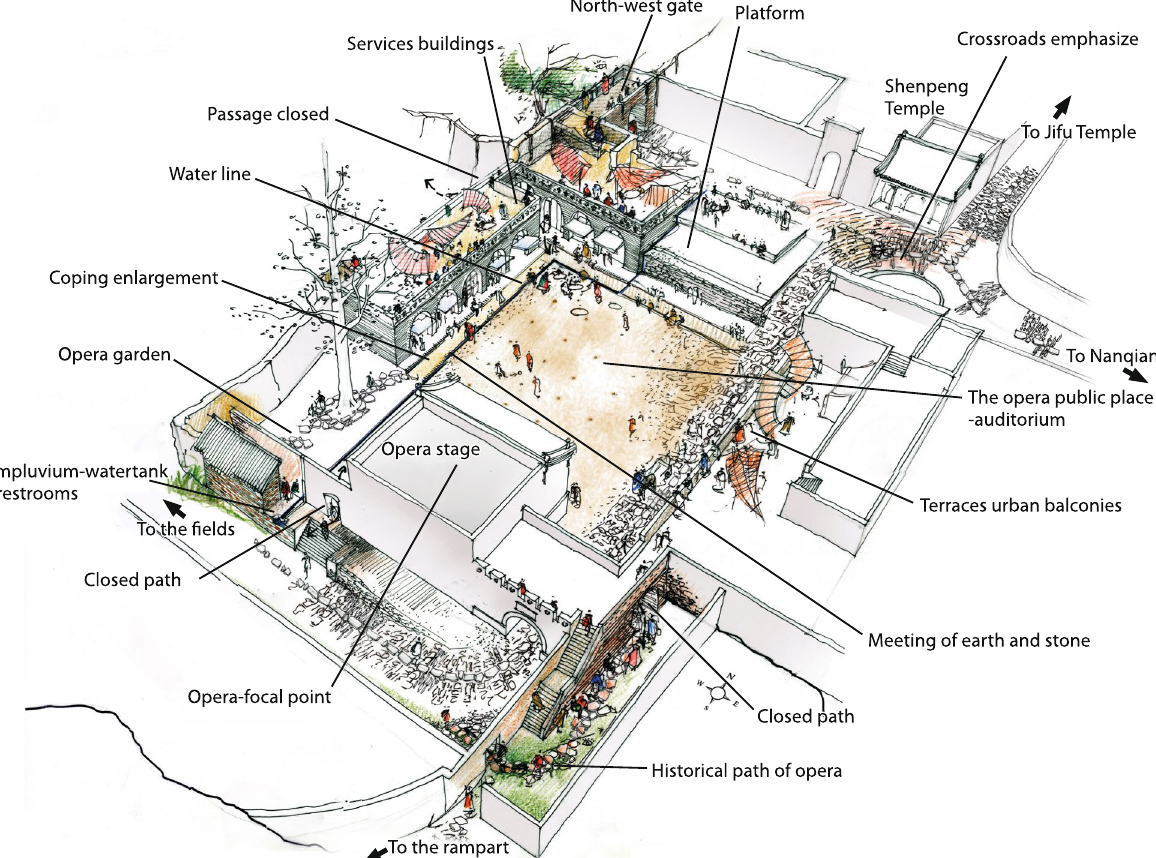
Fig. 21 Regeneration of the stage square and recovery of the microterrain (Source: Tongji University and Ecole de Chaillot 2010)